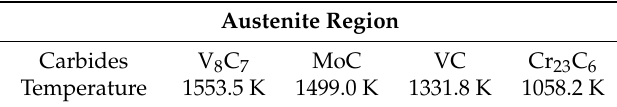
Table 3. Precipitation temperatures of carbides in H13 during solidification.